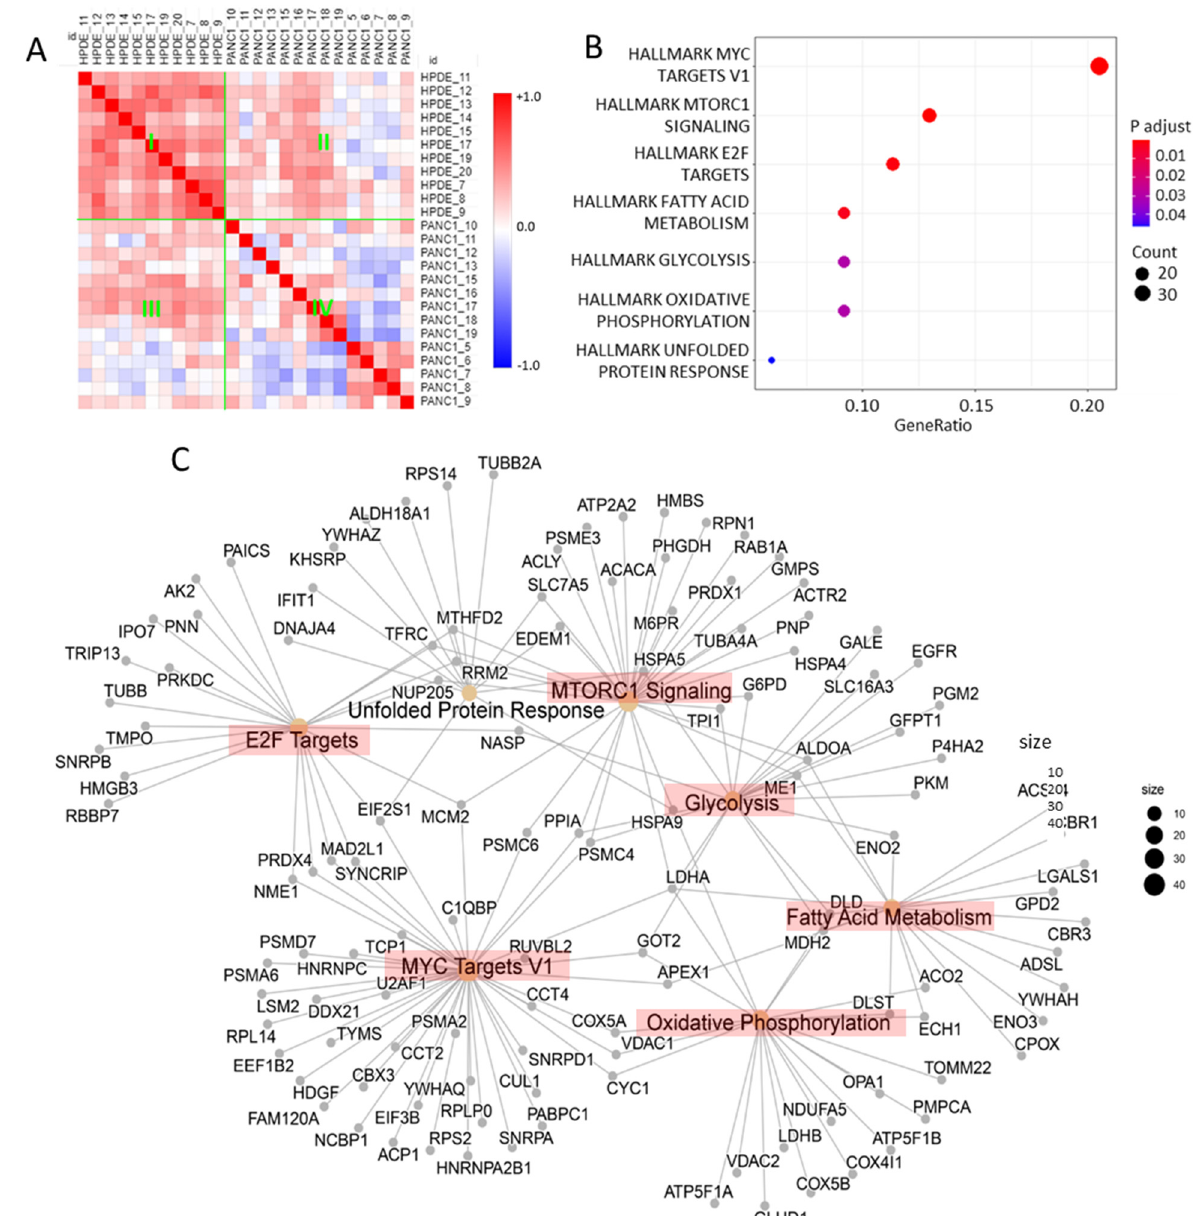
Figure 5. Similarity and functional analysis of the overexpressed proteins associated with PANC-1 cells. ( A ) Similarity matrix of the overexpressed proteins associated with PANC-1 based on Pearson correlation. The overexpressed proteins were highly correlated among the HPDE cells (Region I), whereas they were poorly correlated in the PANC-1 cells (Region IV) due to greater cellular het- erogeneity. ( B ) Cancer hallmark enrichment analysis of the overexpressed proteins associated with PANC-1. ( C ) Network of the overexpressed proteins involved in the cancer hallmarks